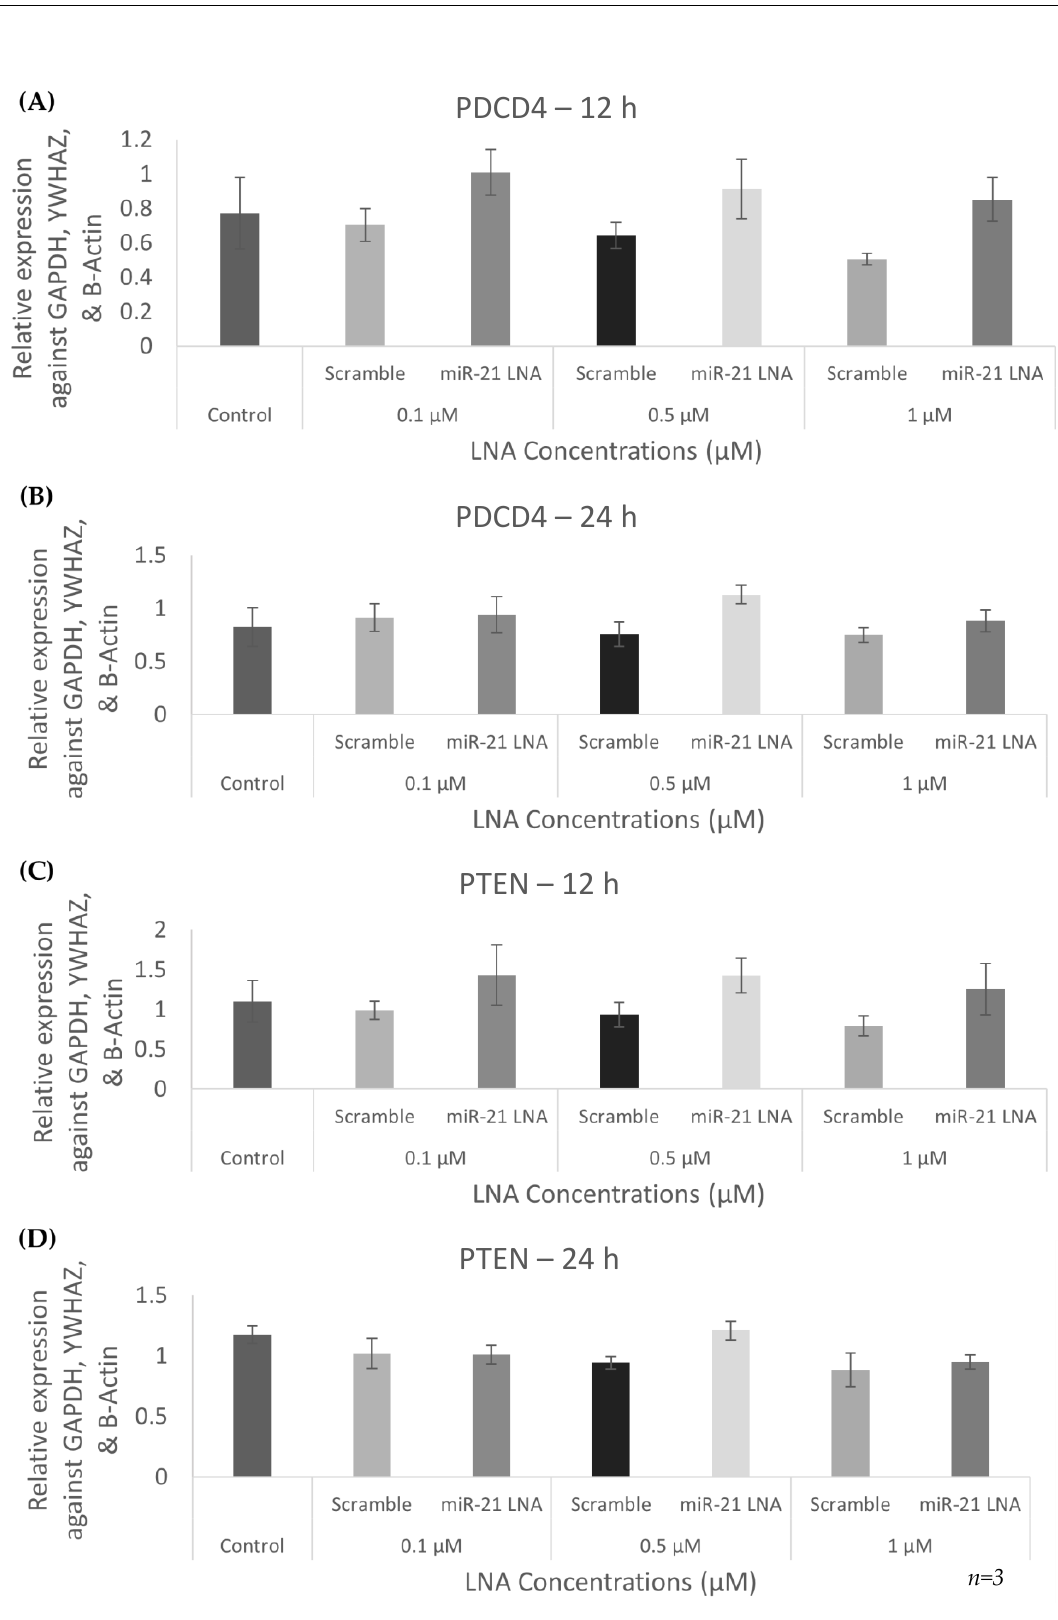
Figure 5. Expression of mRNA targets at different LNA concentrations . PDCD4 ( A , B ) and PTEN ( C , D ) transcripts were unaffected by miR-21 LNA transfections. Cells were transfected with LNA probes at 0.1 µ M, 0.5 µ M, and 1 µ M for 12 h ( A , C ) and 24 h ( B , D ). Quantification is relative to reference genes YWHAZ and b-actin. Bars represent the mean ±